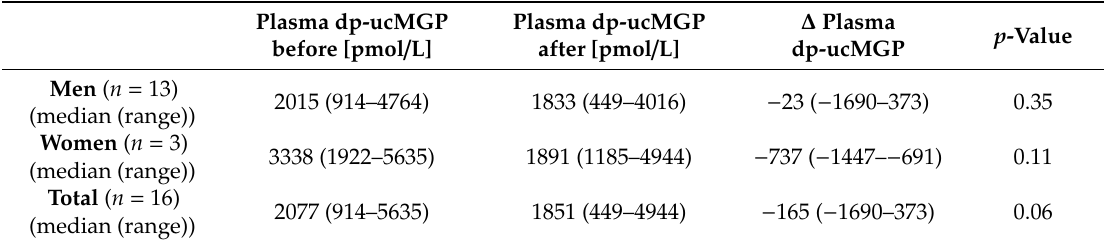
Table 4. Plasma dp-ucMGP concentrations before and after 14 days of Renilon supplement in haemodialysis patients—differences in concentrations are shown.